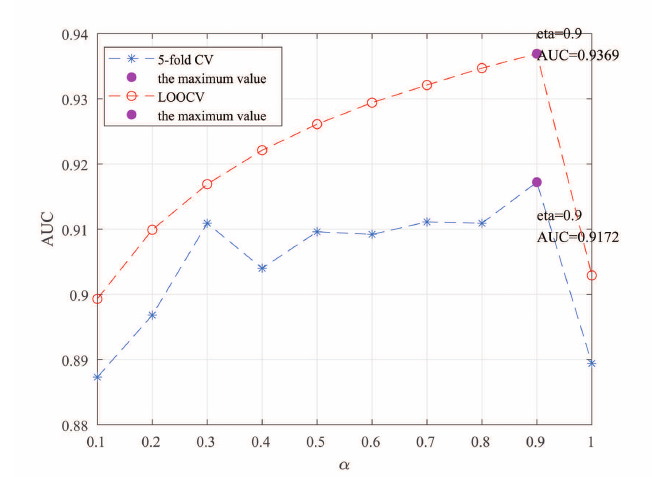
Figure 14. Sensitivity analysis of parameter α